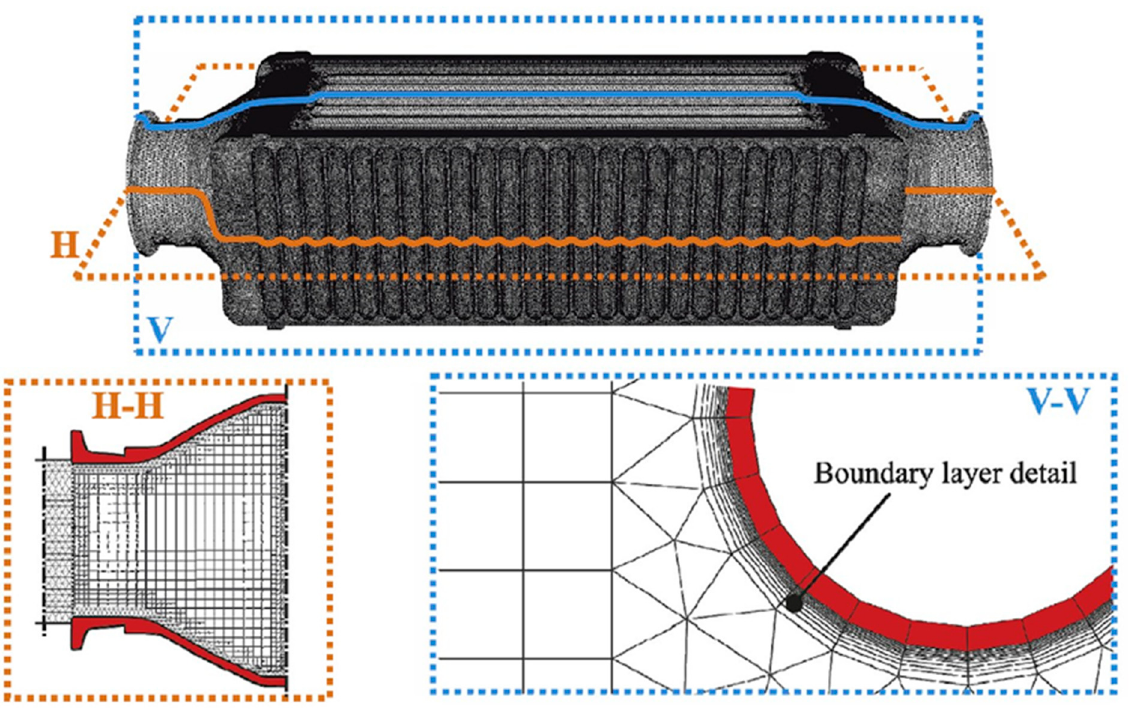
Figure 3. Detail of the mesh in the gas side, where H-H is a horizontal cutting plane, and V-V is a vertical cutting plane.